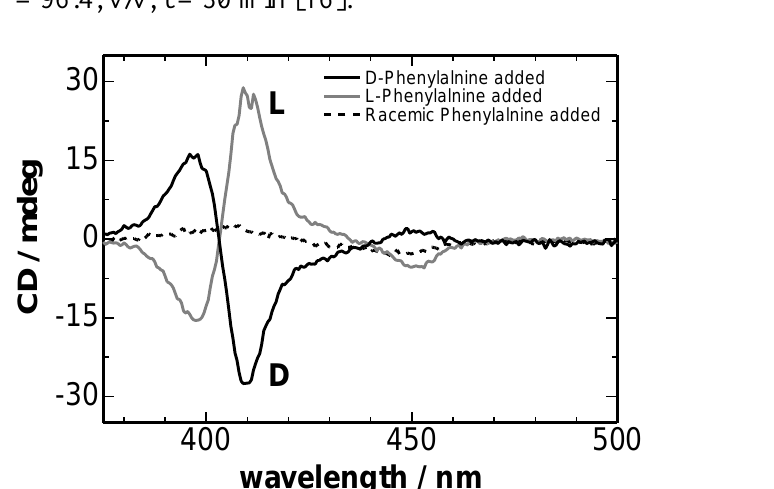
= 8.0 × 10 −6 M, [CuTPPS 4- ] = 7.2 × 10 −5 org aq